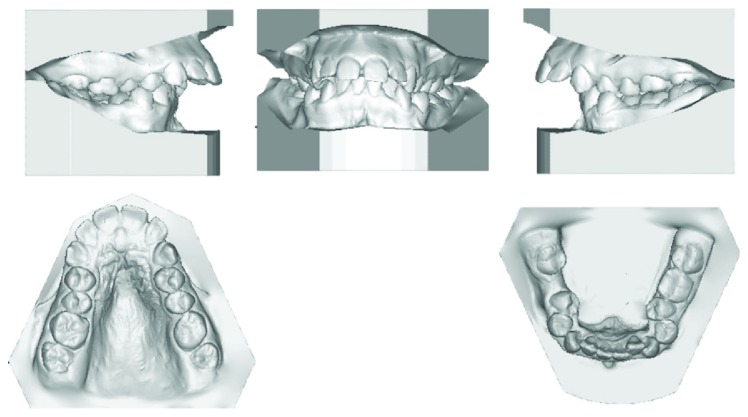
Pretreatment models.